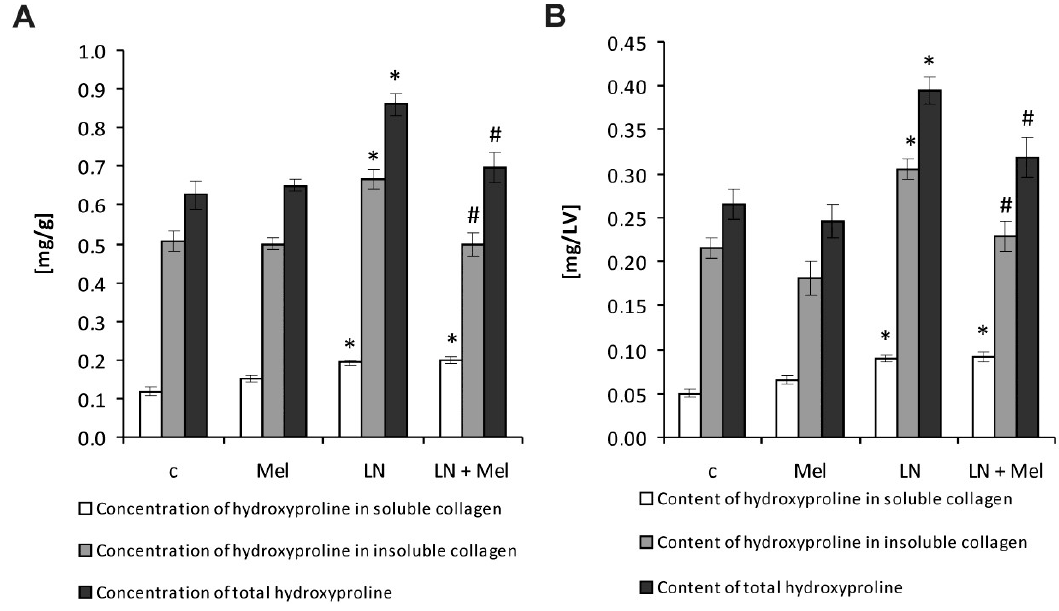
Figure 2. The influence of melatonin (LN + Mel) on hydroxyproline concentration in soluble and insoluble collagen proteins and on total hydroxyproline concentration ( A ) and content ( B ) in L -NAME-treated rats. Wistar controls (c); L -NAME (LN); melatonin (Mel); n = 10 per group; * p < 0.05 vs. c; # p < 0.05 vs. LN.